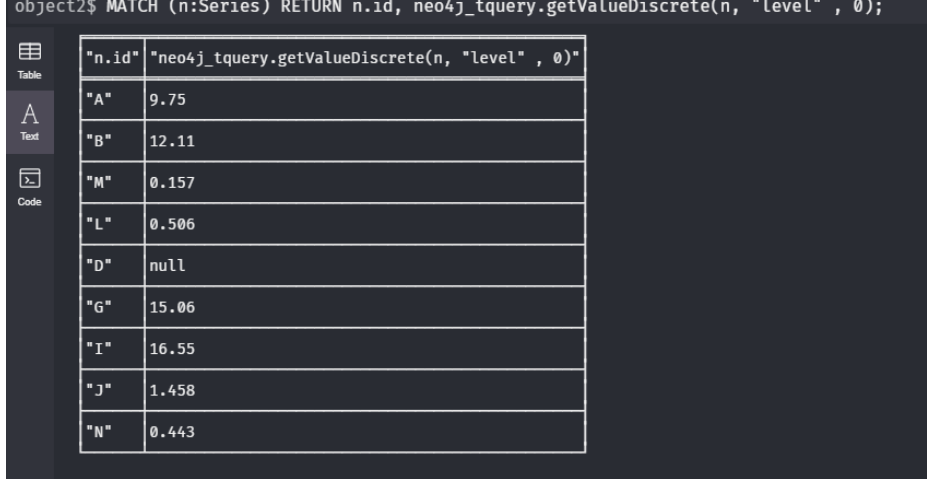
Figure 5. Visualization of the output of query Q 1 run on the sensor network of Figure 4. The result is taken from the web interface of